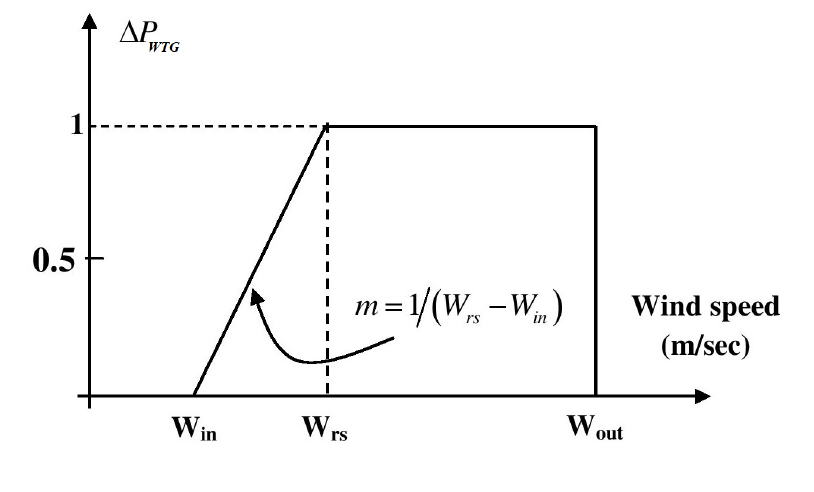
Figure 2. Characteristic of the wind